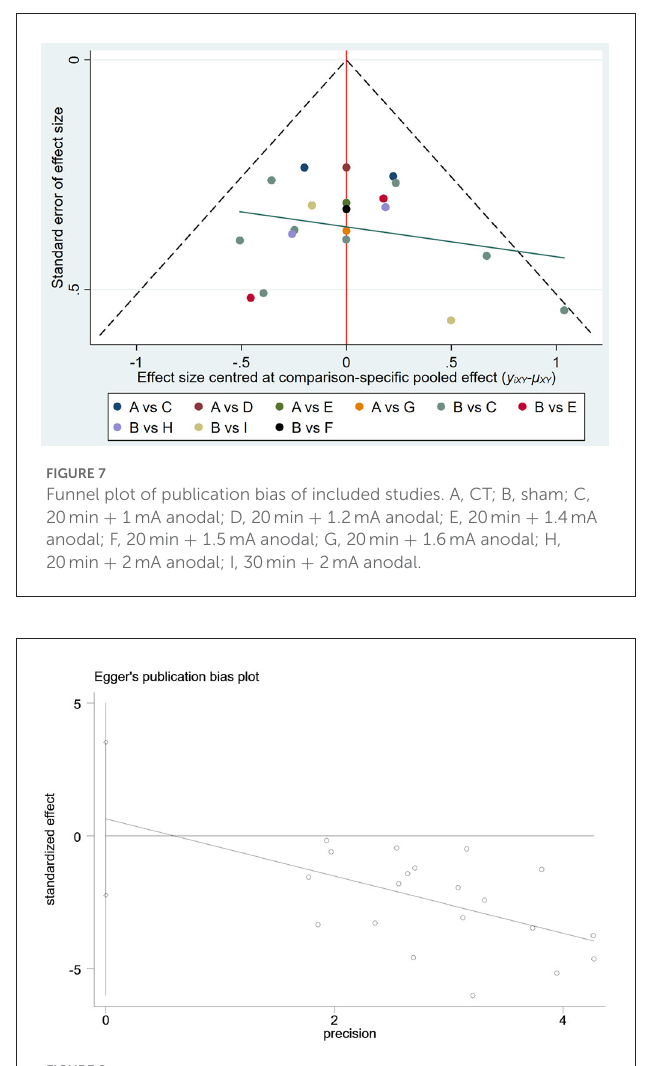
FIGURE8 Egger’s test of publication bias of included